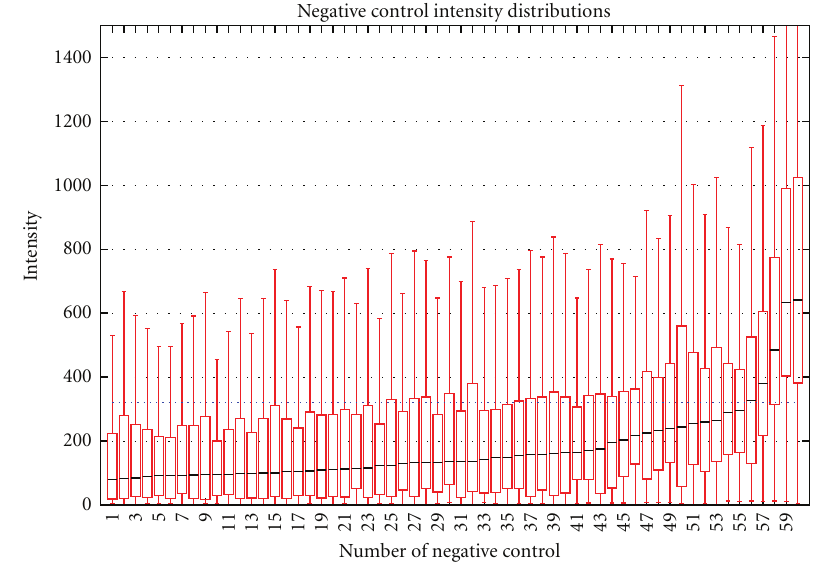
Figure 4: Signal distribution of BOM negative controls. The median signal intensity for negative controls was calculated and compared to the average signal from noncontrols (blue line). The minimum and maximum intensity values for each negative control (vertical lines), the first and third quartiles (white boxes which contain 50% of the values), and the median (black line) are presented. Summary of results from 72 hybridizations representing 6 tissues from 6 animals, with two technical replicates at two locations is presented.